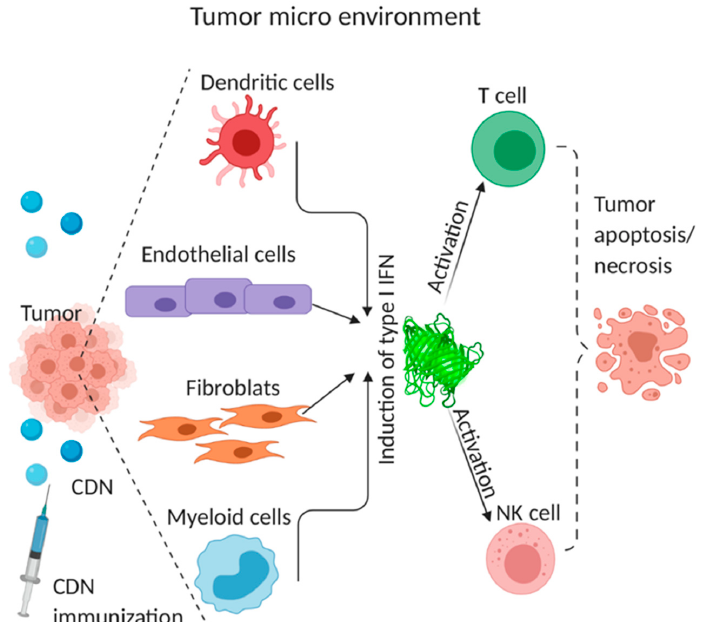
Figure 3. In vivo CDN-induced, type I IFNs-mediated anti-tumor immunity. The CDN immunization in the tumor microenvironment (TME) activates the STING pathway in DCs, endothelial cells, fibroblasts, and myeloid cells, leading to the production of type I IFNs. Type I IFNs act as a stimulus for DC to induce CD8 + T cell cross-priming. Type I IFNs also activate natural killer (NK) cells leading to NK cell-mediated cytotoxicity and tumor cell killing.